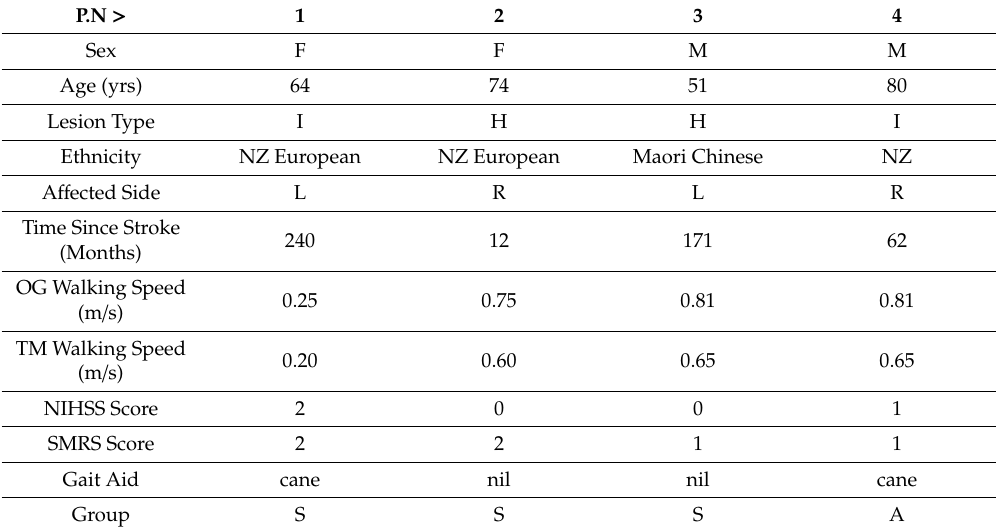
Table 2. Demographics and stroke